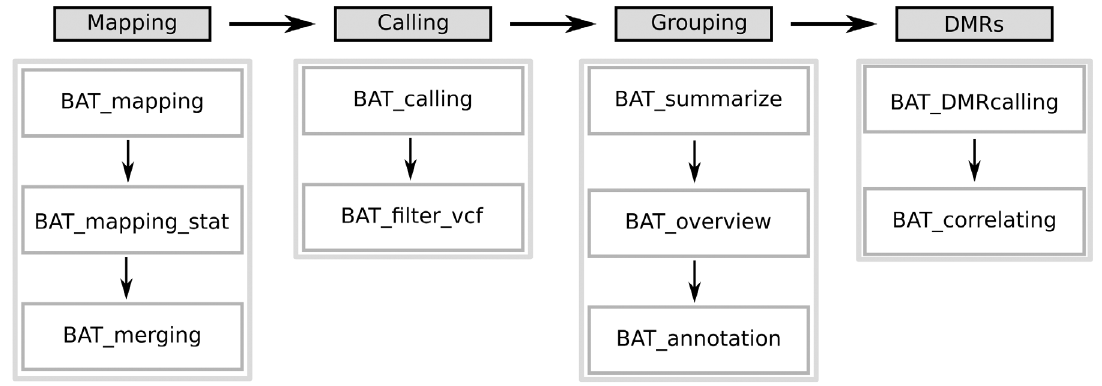
Figure 1. BAT workflow. It comprises four modules covering (left to right) read alignment, methylation rate calling, basic group analysis, and DMR calling. The modules consist of a collection of scripts that build up on one another, but easily single steps can be covered by alternative